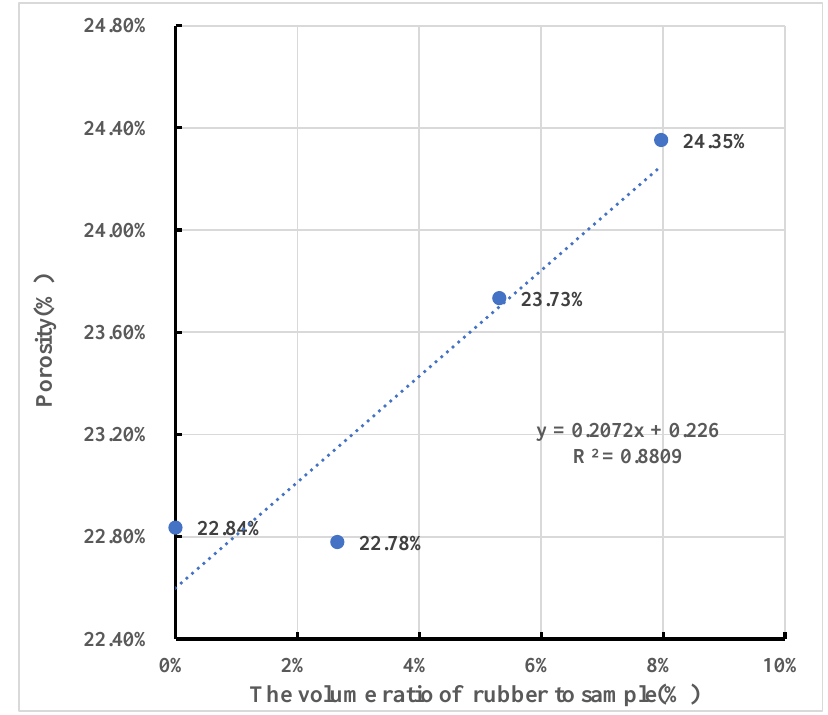
Figure 18. The effect of rubber content on the porosity of CRM.